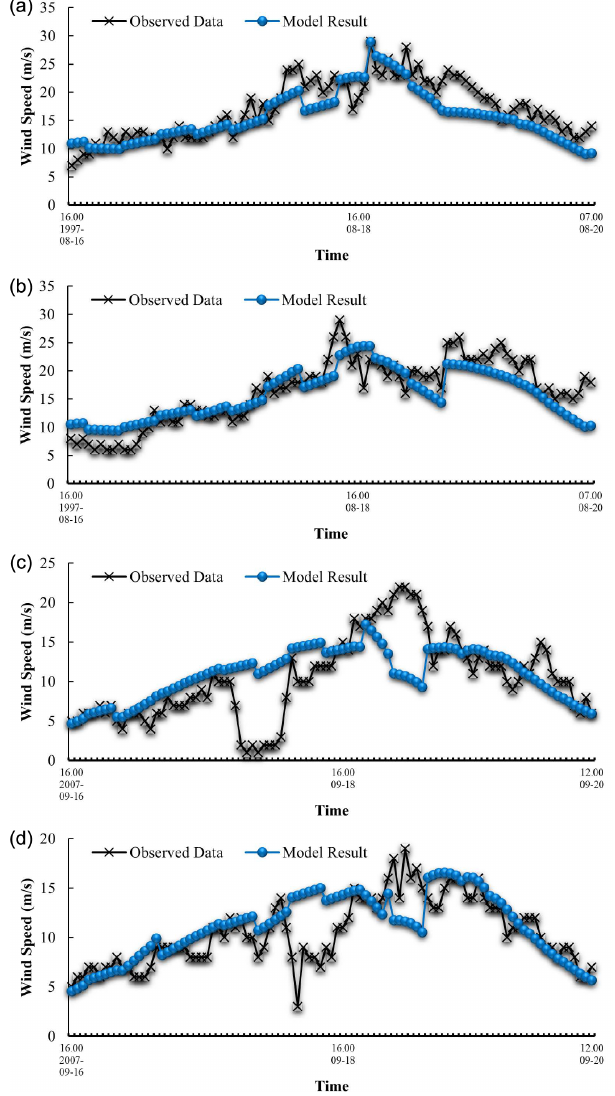
Figure 5. Data comparison between computed wind speed (ms − 1 ) and observed data at the two wind gauge stations in Shanghai during typhoons Winnie and Wipha. The blue line presents the simulated results from the typhoon model, while the black line indicates the measured data at the gauge stations. (a, b) Winnie and (c, d) Wipha at Daji and Tanxu